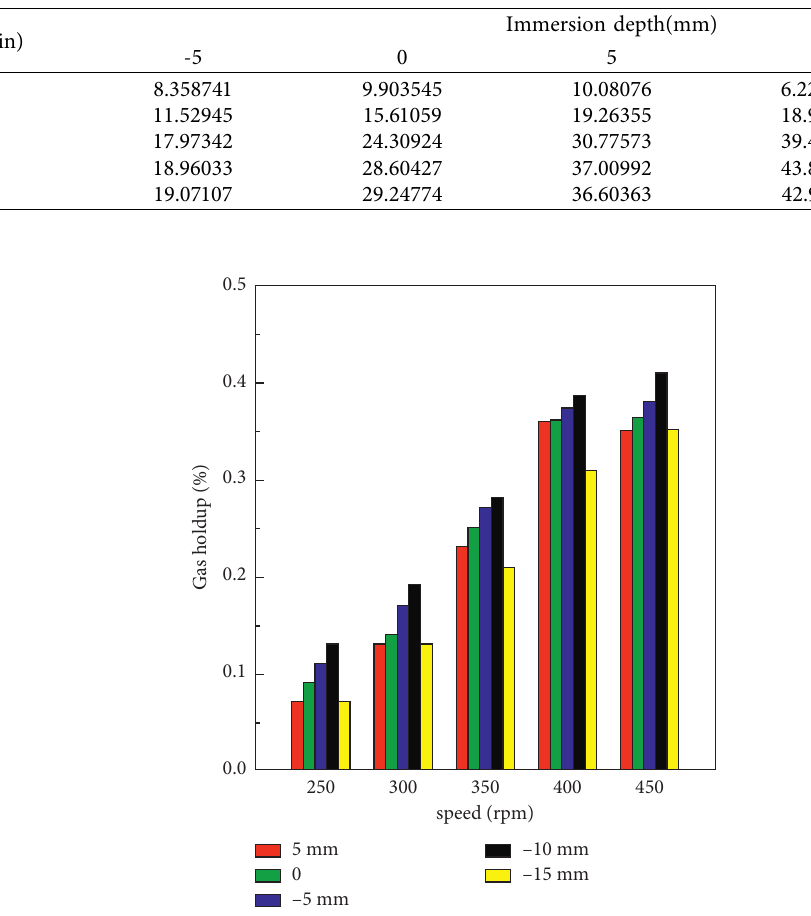
Table 3: Standard dynamic efficiency SAE under different motion parameters.